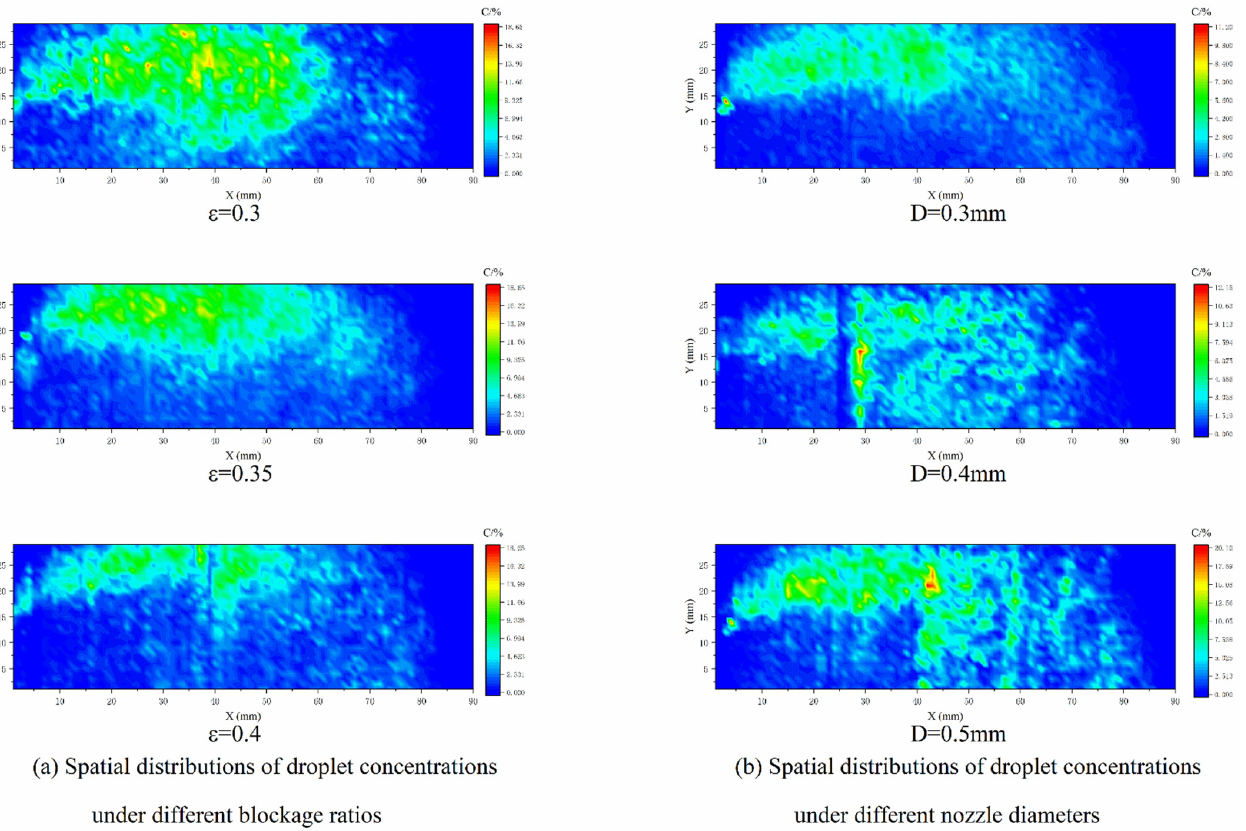
Figure 16. Spatial distributions of droplet concentrations.